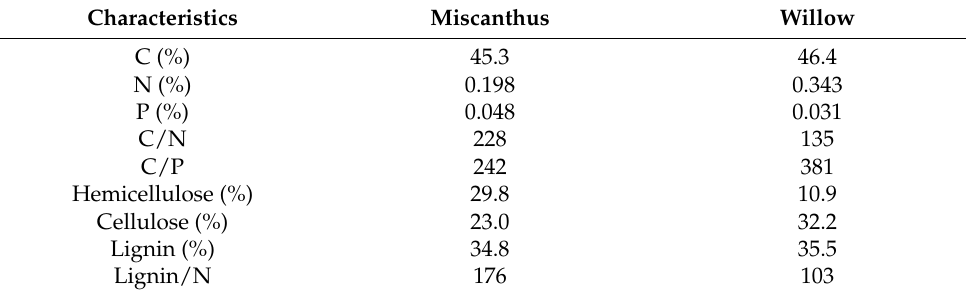
Table 1. Characteristics of the chopped plant material.